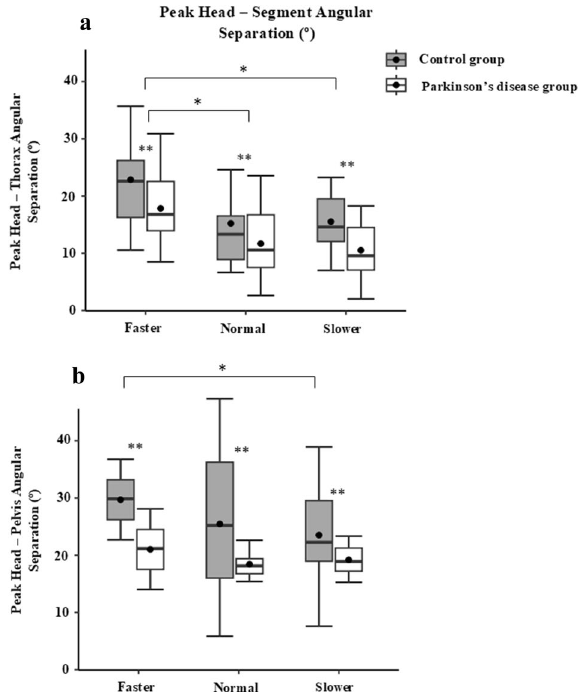
separation and ( b ) peak head-pelvis angular separation. (*—significant main effect of turn speed and **— significant main effect of